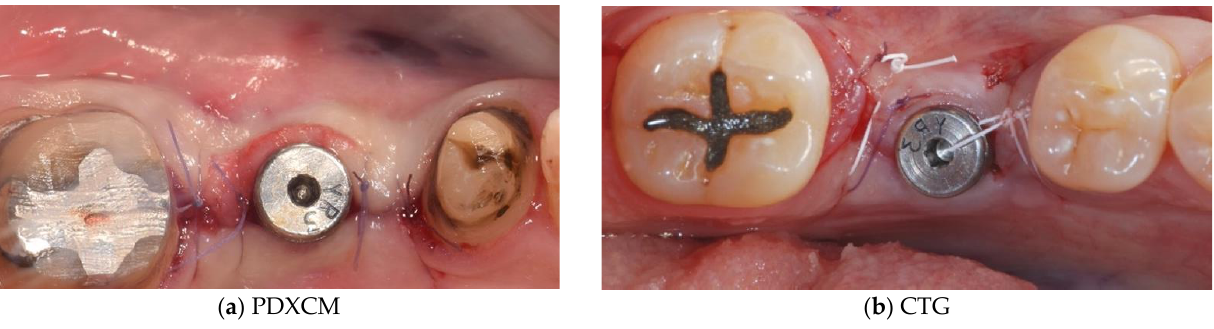
Figure 5. ( a , b ) the PDXCM is completely covered by the flap which ensures a double vascularization. The double vascularization is essential to guarantee to both side of the graft the opportunity of a quick integration with the surrounding tissue.